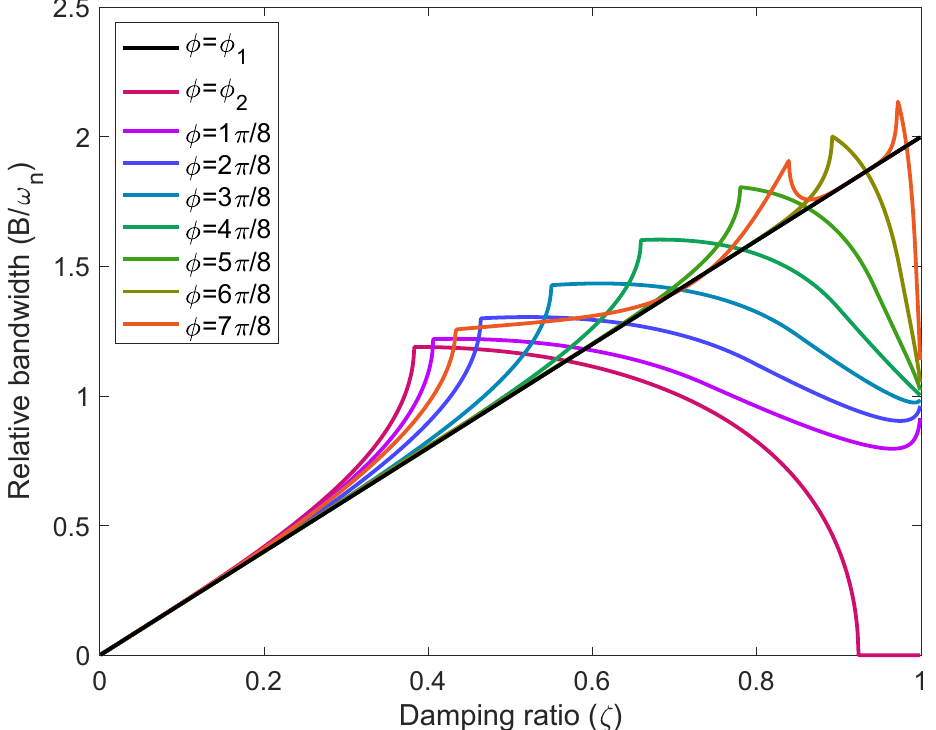
Figure 7. Relative bandwidth ( B / ω n ) of a single underdamped mode, with respect to the damping factor ( ζ ) for different phase values ( φ